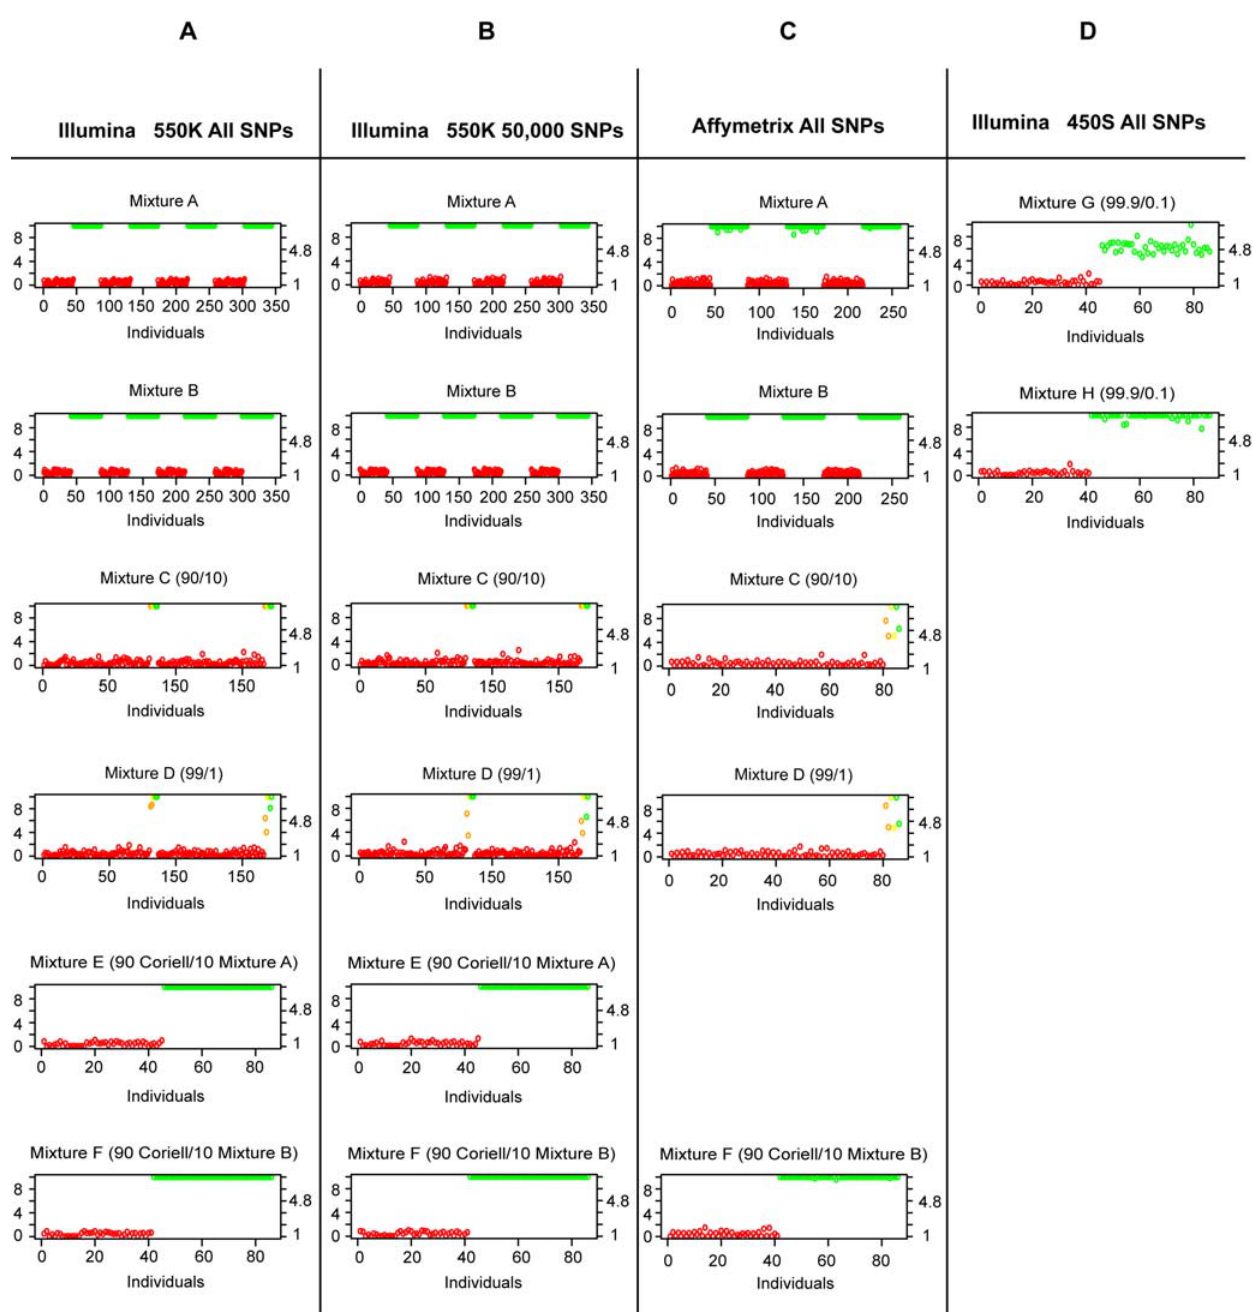
Figure 3. Experimental validation using a series of mixtures (see Methods A–F) assayed on the Affymetrix GeneChip 5.0, Illumina BeadArray 550 and the Illumina 450S Duo Human BeadChip. The x-axis shows each individual in the CEU HapMap population, the left y-axis shows the p-value (log scaled), and the right y-axis shows the value of the test statistic. For mixtures A, B, E and F those in the mixture are colored green and those not in the mixture are colored red. For mixtures C and D those individuals who are not in the mixtures are colored red, those individuals who are related to the 1% or 10% individuals in the mixtures are colored orange, those individuals who are related to the 90% or 99% are colored yellow, and those people in the mixture are colored green. In all mixtures, the identification of the presence of a person’s genomic DNA was possible.